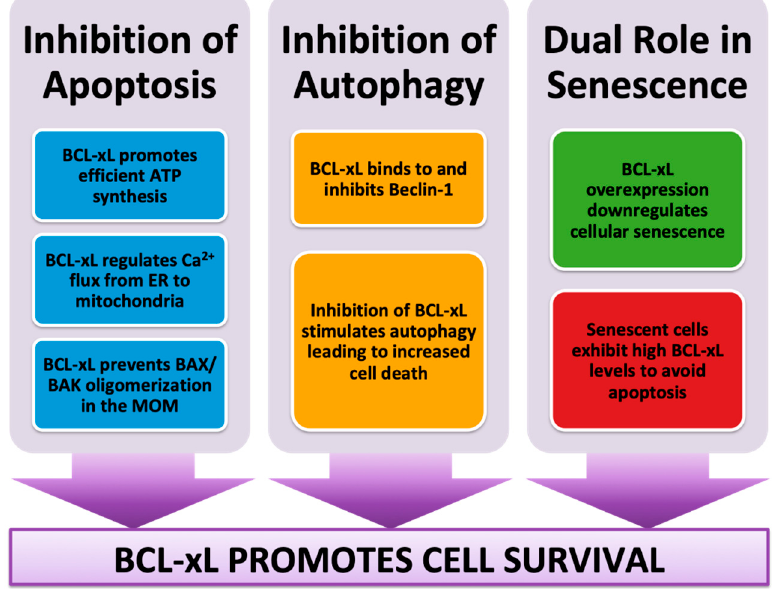
Figure 3. BCL-xL promotes cell survival through apoptosis, autophagy, and senescence regulation.